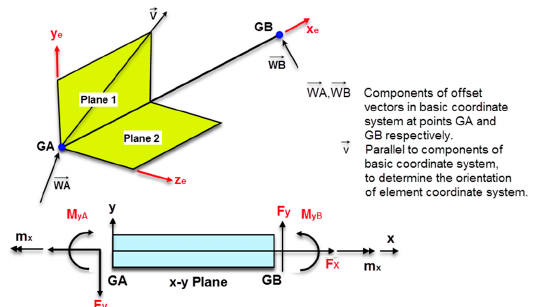
Figure 9. Moments and internal forces in the element coordinate system.